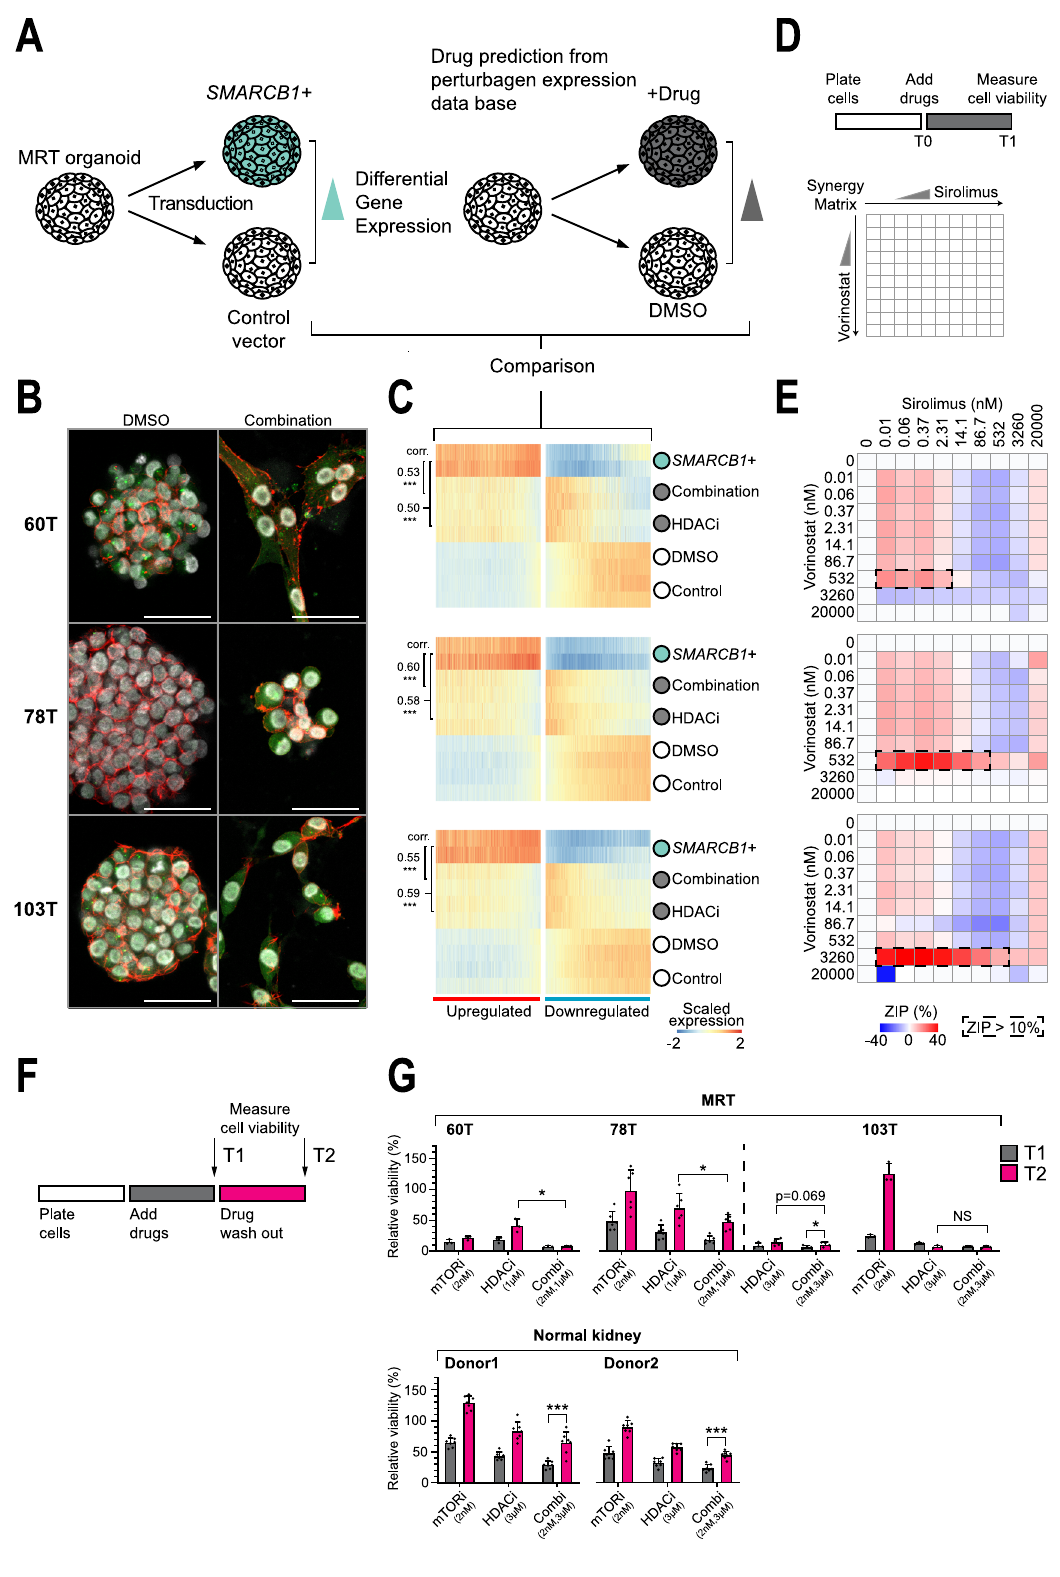
Methods Ethics statement . Tumour and normal tissues used for genetic lineage tracing (Supplementary Table 1) were obtained as part of the SIOP2001 study approved by the medical ethical committees of the institutes involved (Ethical Committee Uni- versity Leuven (Belgium), Medical ethical committee of the Erasmus Medical Centre Rotterdam (the Netherlands)), or were obtained from the Children ’ s Cancer and